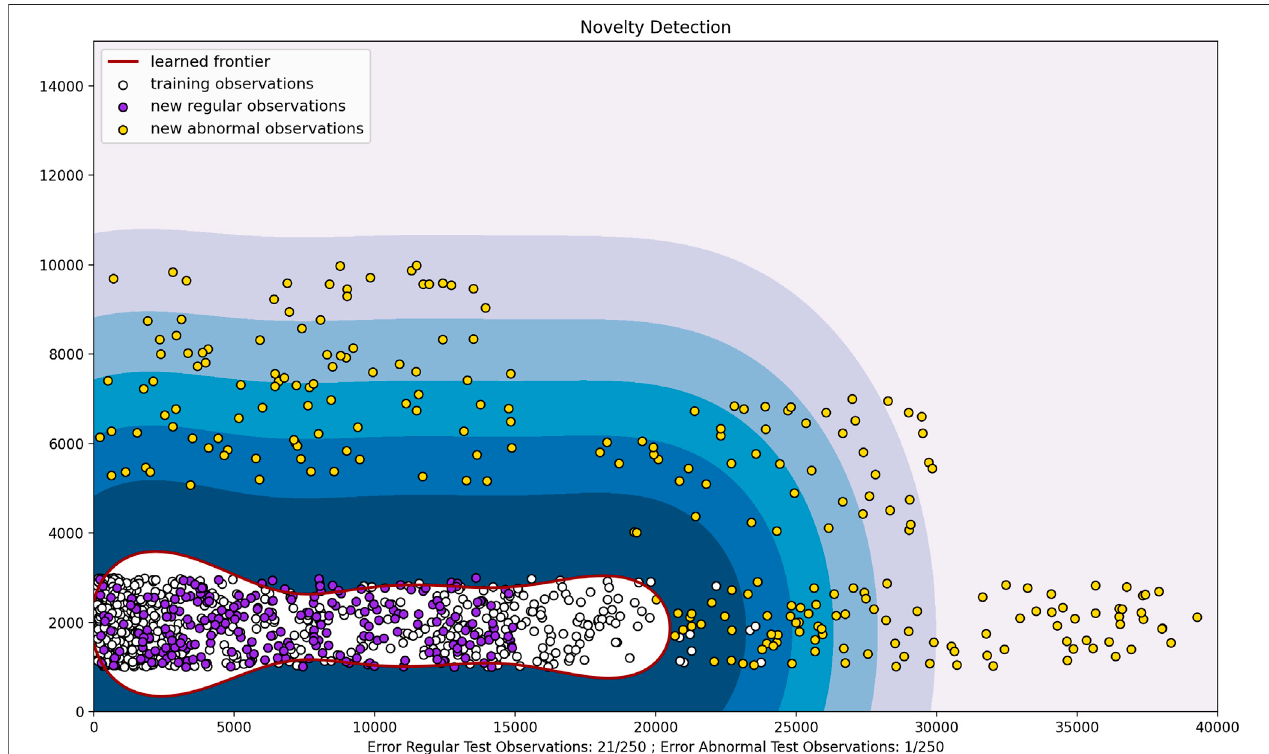
FIGURE 10 | Output plot for OC-SVM.